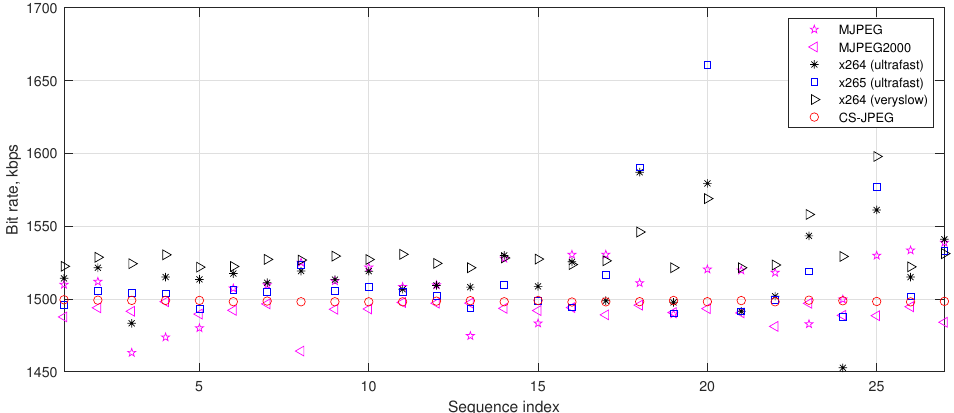
Figure 8. Bit rate provided by the considered codecs for R T = 1500